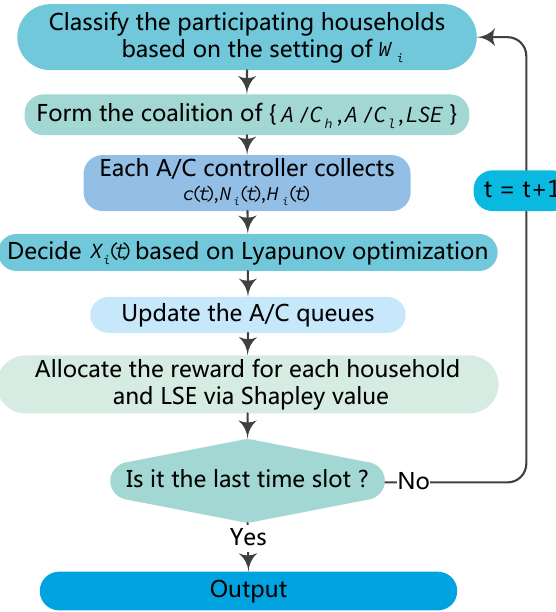
Figure 2. Flowchart of the operation strategy in the smart community. LSE: load serving